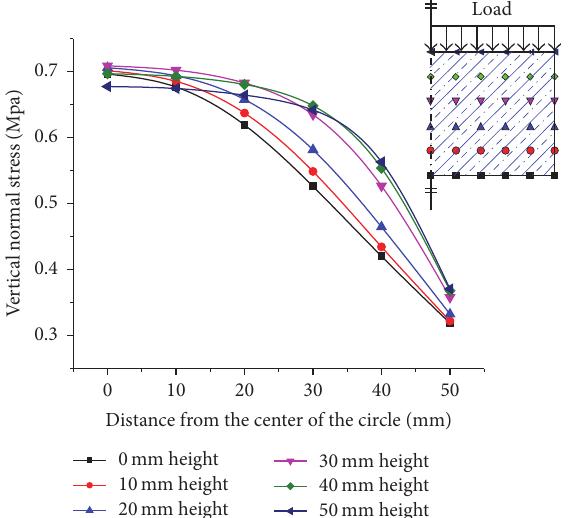
Figure 7: Distribution of vertical stress under the loading area.